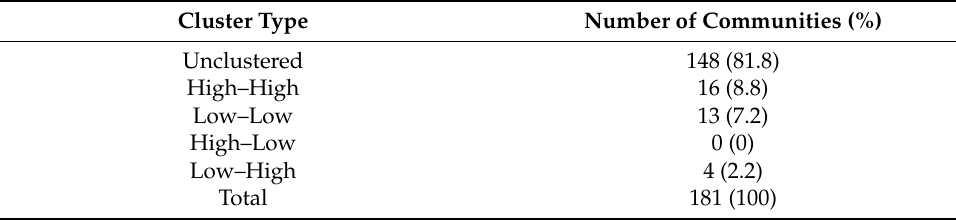
Figure 7. Cluster types of accessibility of medical facilities in Changning District. Table 6. Localized clusters of spatial accessibility based on LISA Table 6. Localized clusters of spatial accessibility based on LISA statistics.